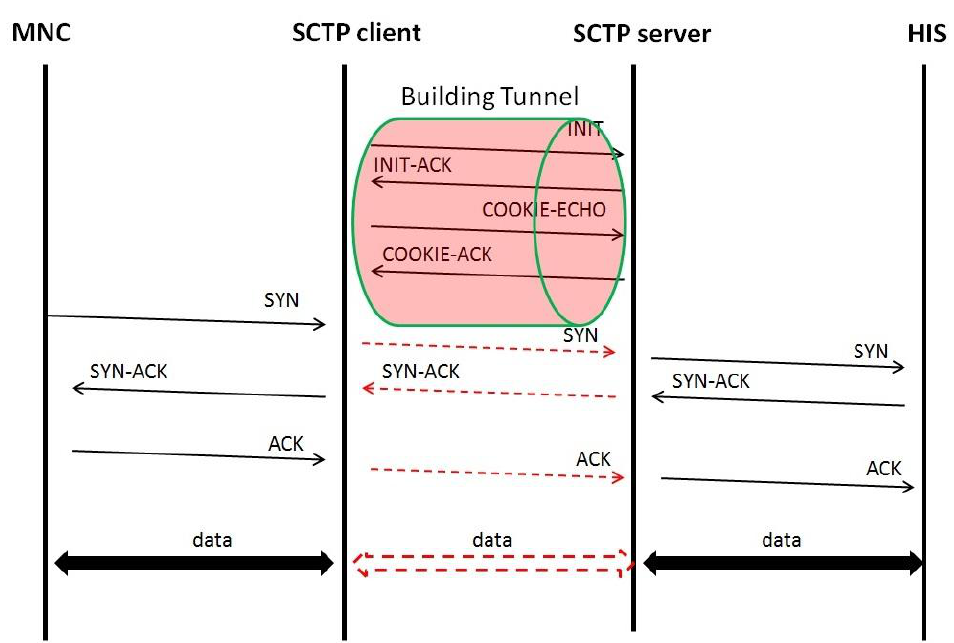
Figure 3. TCP three-way handshaking in the